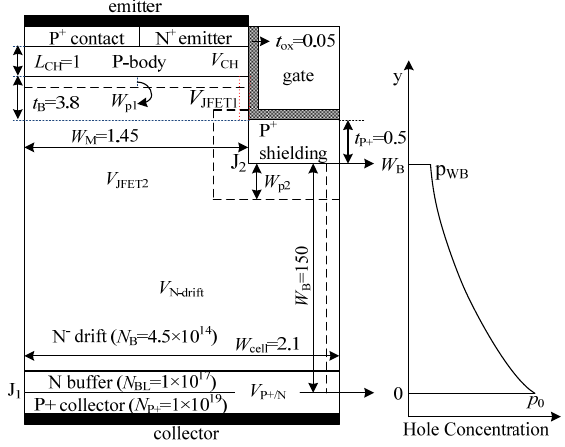
Figure 1. Forward voltage drop distribution and hole concentration profile.